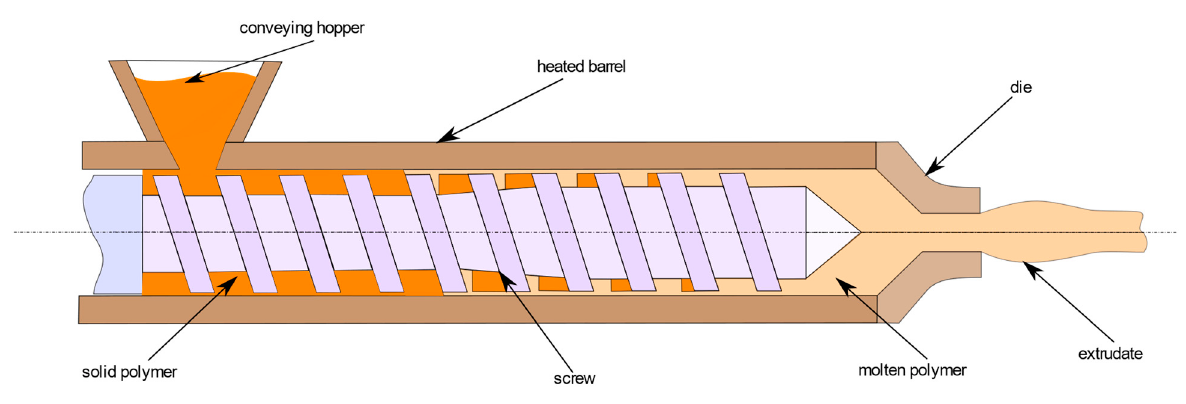
Figure 3. Scheme of the extrusion process in IM .